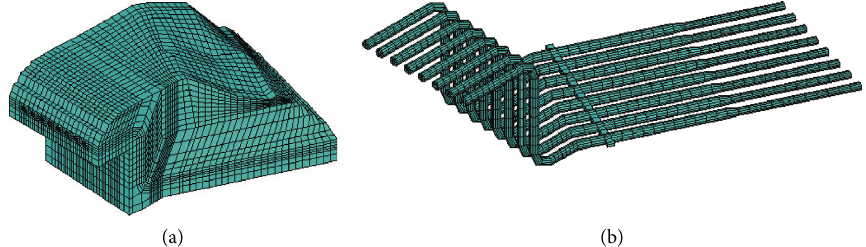
Figure 7: Geometry model for the 3D numerical experiment: (a) whole 3D model and (b) model 8